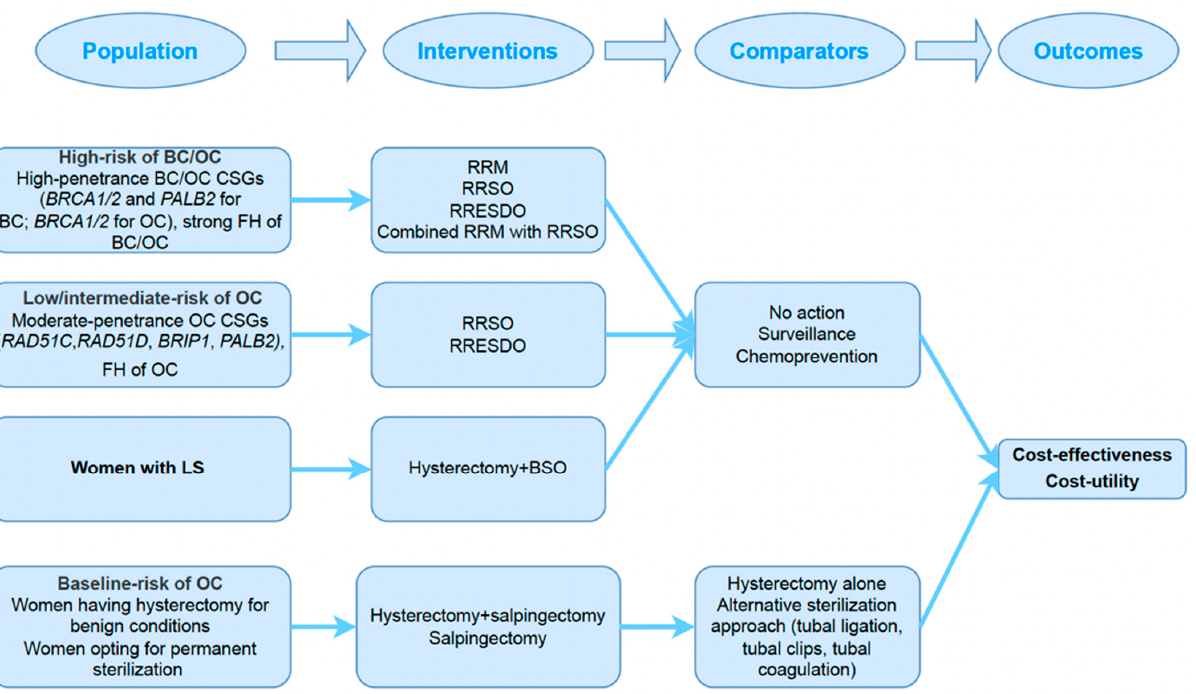
Figure 1. Systematic review protocol. BC, breast cancer; BSO, bilateral salpingo-oophorectomy; CSGs, cancer susceptibility genes; FH, family history; LS, Lynch syndrome; OC, ovarian cancer; RRESDO, risk-reducing early salpingectomy with delayed oophorectomy; RRM, risk-reducing mastectomy; RRSO, risk-reducing salpingo-oophorectomy.